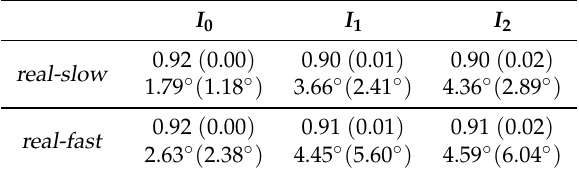
Table 4. Mean (std) of magnetic field vector 2-norms (upper values) and global angular deviations (lower values) for each IMU as calculated from the real data